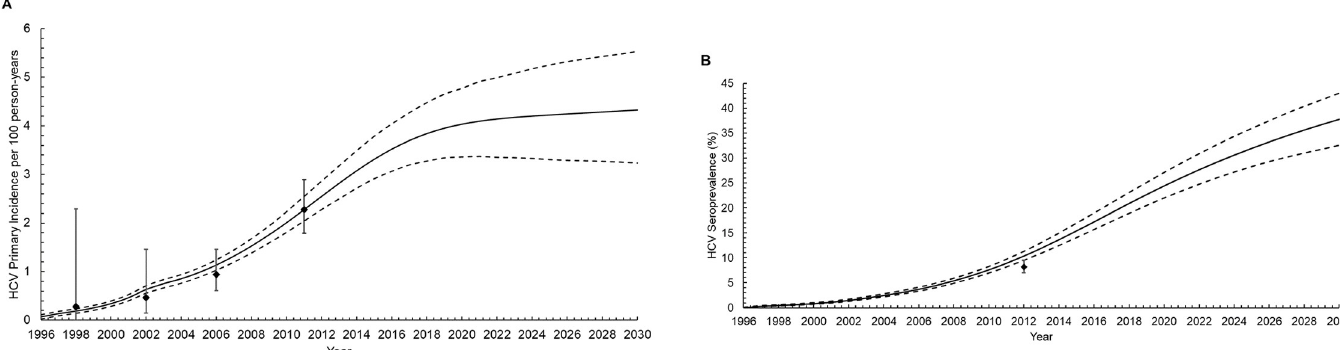
Fig 1. Model fit to calibration data for primary hepatitis C virus (HCV) incidence (A) and HCV seroprevalence (antibody or RNA positive) (B) among men who have sex with men living with diagnosed human immunodeficiency virus (HIV) in Germany. Diamonds represent mean epidemiological data estimate; whiskers, 95% confidence intervals; solid lines, the mean model trajectories; dashed lines, the 2.5% and 97.5% confidence percentiles of